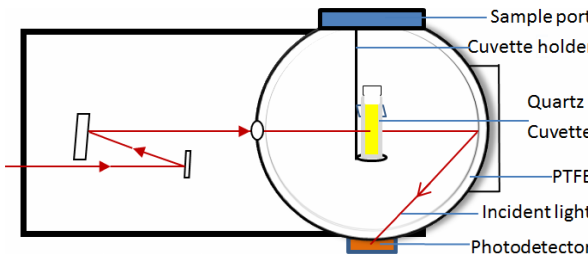
Figure 1. The sketch of the integrating sphere (IS) method. PTFE means